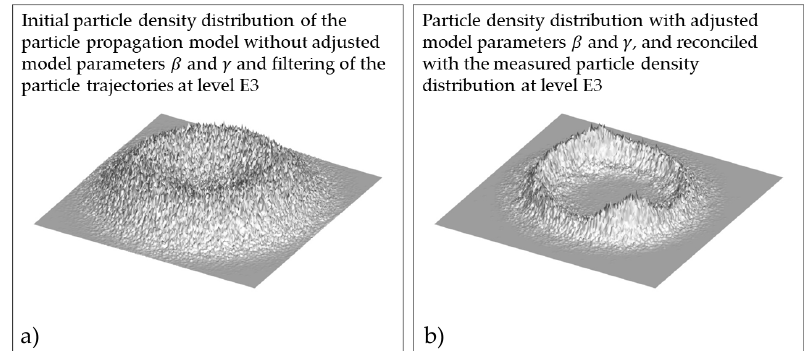
Figure 15. ( a ) Particle density distribution with a suitable selection of model parameters β and γ at level E3 and on the basis of the initial distribution, which is Gaussian with respect to r and uniform with respect to ϕ . ( b ) Particle density distribution after a statistical filtering of particle trajectories [1]. Reprinted with permission from Ref [1]. Copyright 2020, Fraunhofer Verlag.